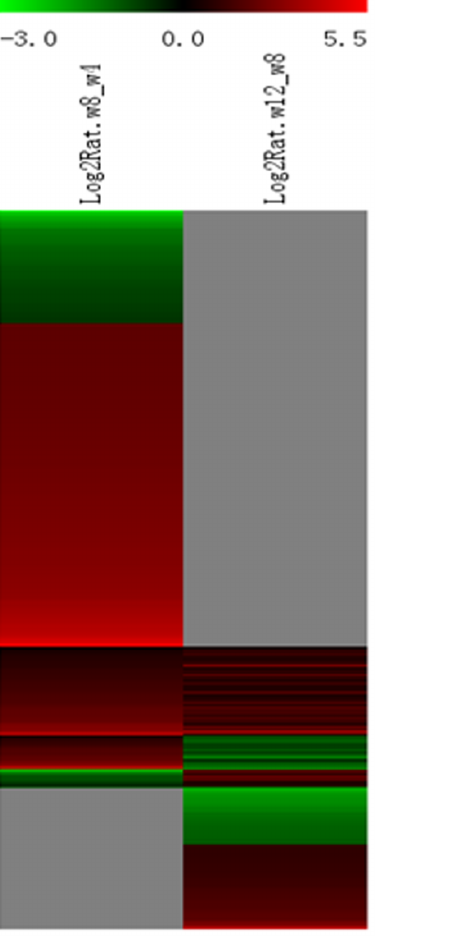
Figure 11. The Heat Map of the genes with dynamic changes between 4–8 weeks and 8–12 weeks of age.